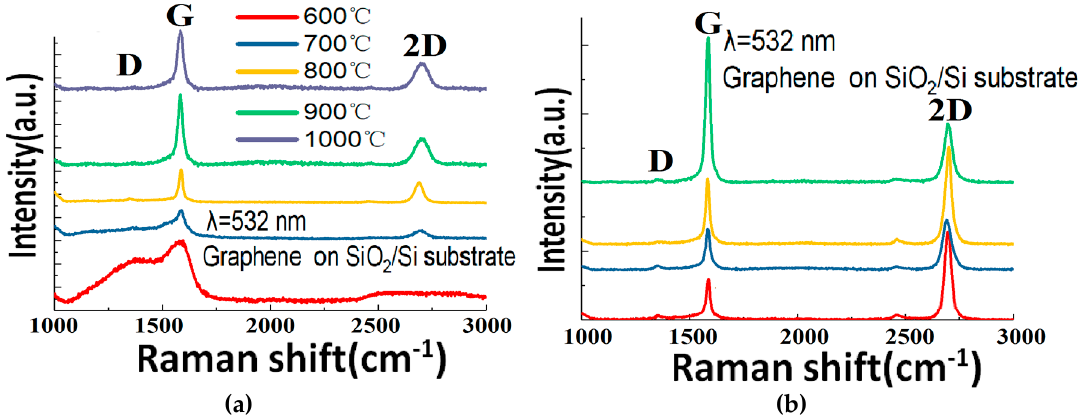
Figure 4. (a) Raman spectra of the graphene grown at different temperatures on Cu-Ni alloy and Figure 4. ( a ) Raman spectra of the graphene grown at di ff erent temperatures on Cu-Ni alloy and transferred to SiO 2 /Si substrates. (b) Raman spectra captured at different positions in the same transferred to SiO 2 / Si substrates. ( b ) Raman spectra captured at di ff erent positions in the same graphene graphene sheet grown on a Cu-Ni alloy at 900 °C and transferred to its SiO 2 /Si substrate. sheet grown on a Cu-Ni alloy at 900 ◦ C and transferred to its SiO 2 / Si